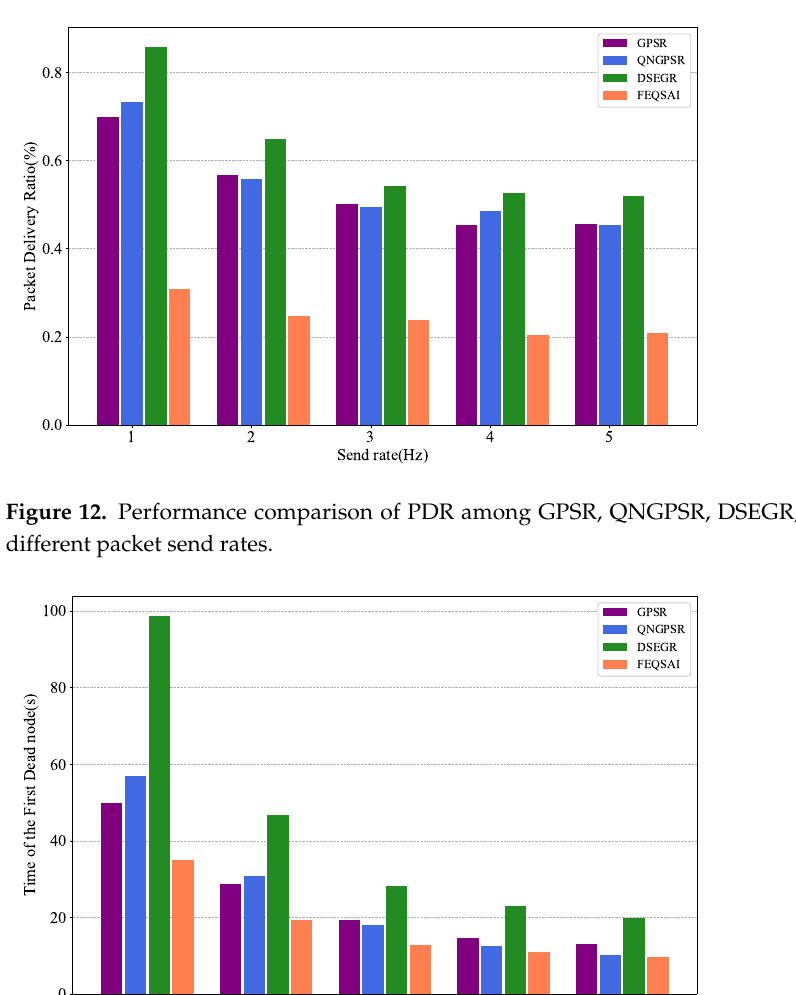
Figure 11. Performance comparison of average E2E delay among GPSR, QNGPSR, DSEGR, and FEQSAI with different packet send rates.